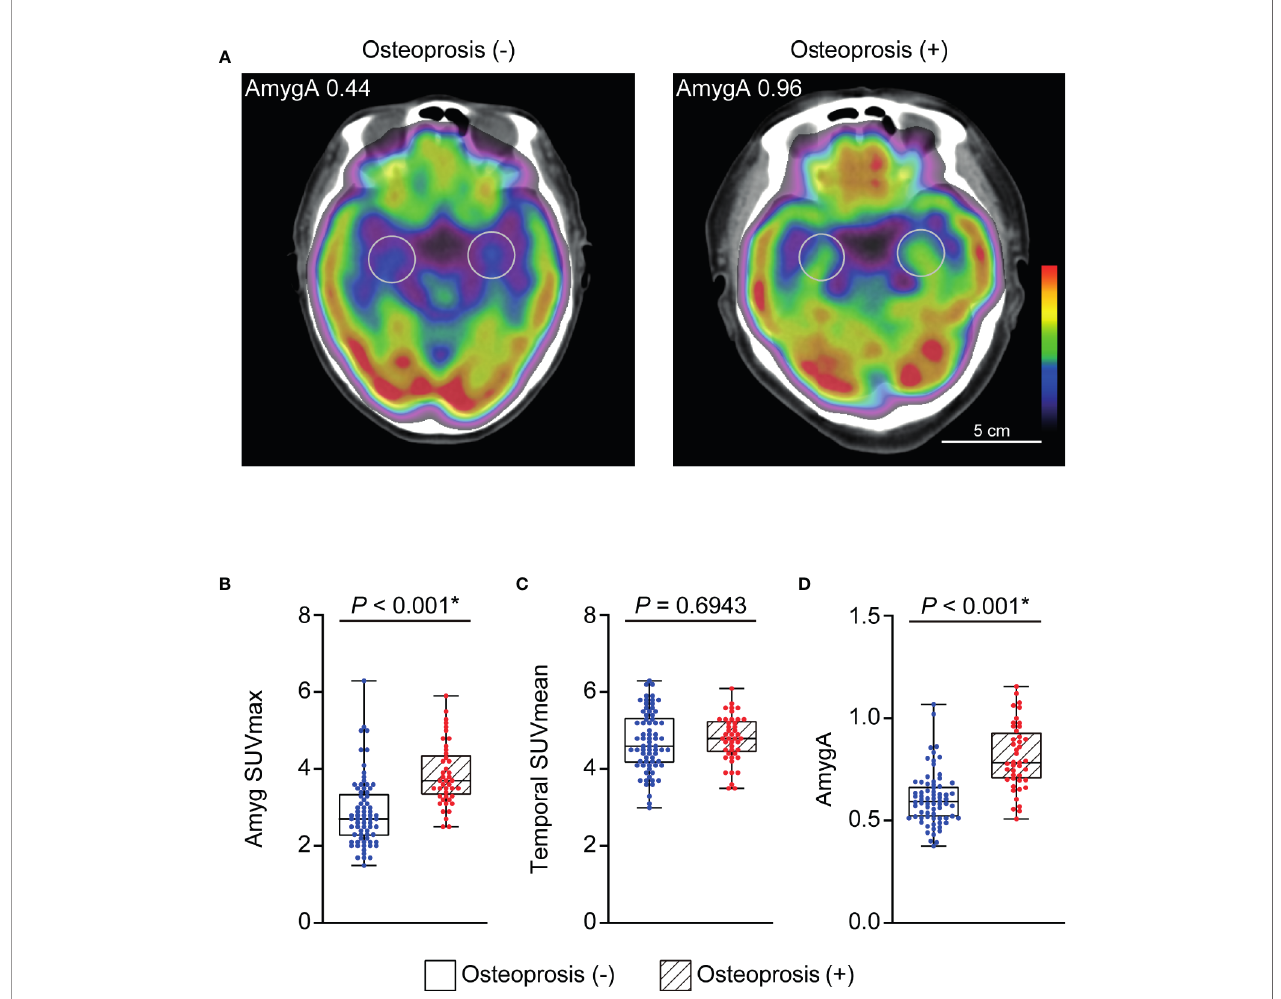
FIGURE 2 | Representative images of AmygA (A) and comparison of Amyg SUVmax (B) , Temporal SUVmean (C) , and AmygA (D) between the postmenopausal women diagnosed with and without osteoporosis. Osteoporosis (-), n = 72; Osteoporosis (+), n = 43. Amyg SUVmax; maximum standardized uptake value of amygdala, Temporal SUVmean; mean standardized uptake value of temporal lobe, AmygA; the metabolic activity of amygdala; Amyg SUVmax/Temporal SUVmean. *Statistically signi fi cant difference. Amyg SUVmax and AmygA were analyzed with Mann-Whitney U test. Temporal SUVmean was analyzed with Student ’ s t -test.